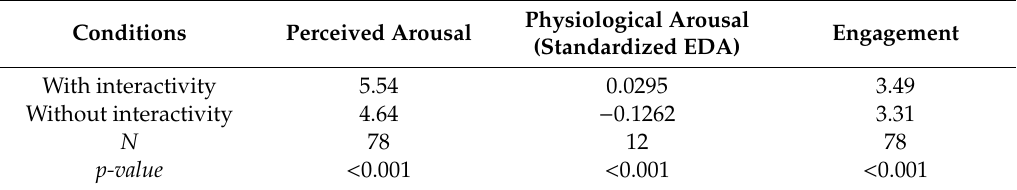
Table 1. Descriptive statistics per